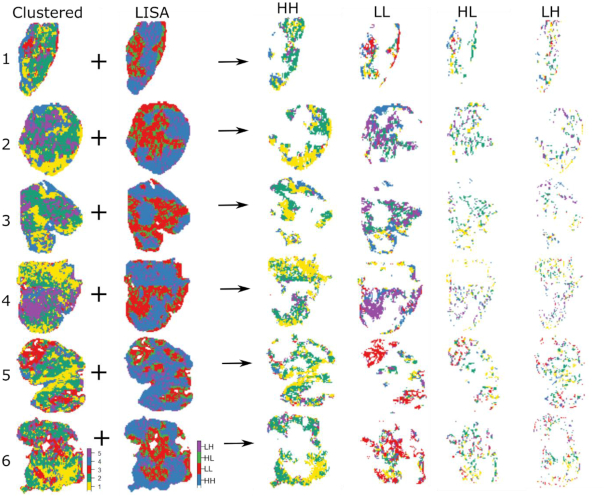
Individual clustered image (first column), LISA map (second column), and their combination are shown for a few tumor models from A2780–1A9 MSI data. The clusters found in high-high (HH), low-low (LL), high-low (HL), and low-high (LH) zones of LISA map are highlighted. In the LISA map, HH, LL, HL, and LH are zones identified in the Moran I scatter plot.